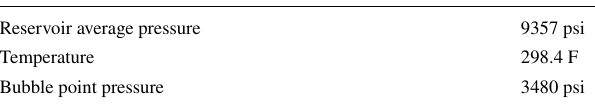
Fig. 4 Inflow performance relation curve Table 4 Reservoir data